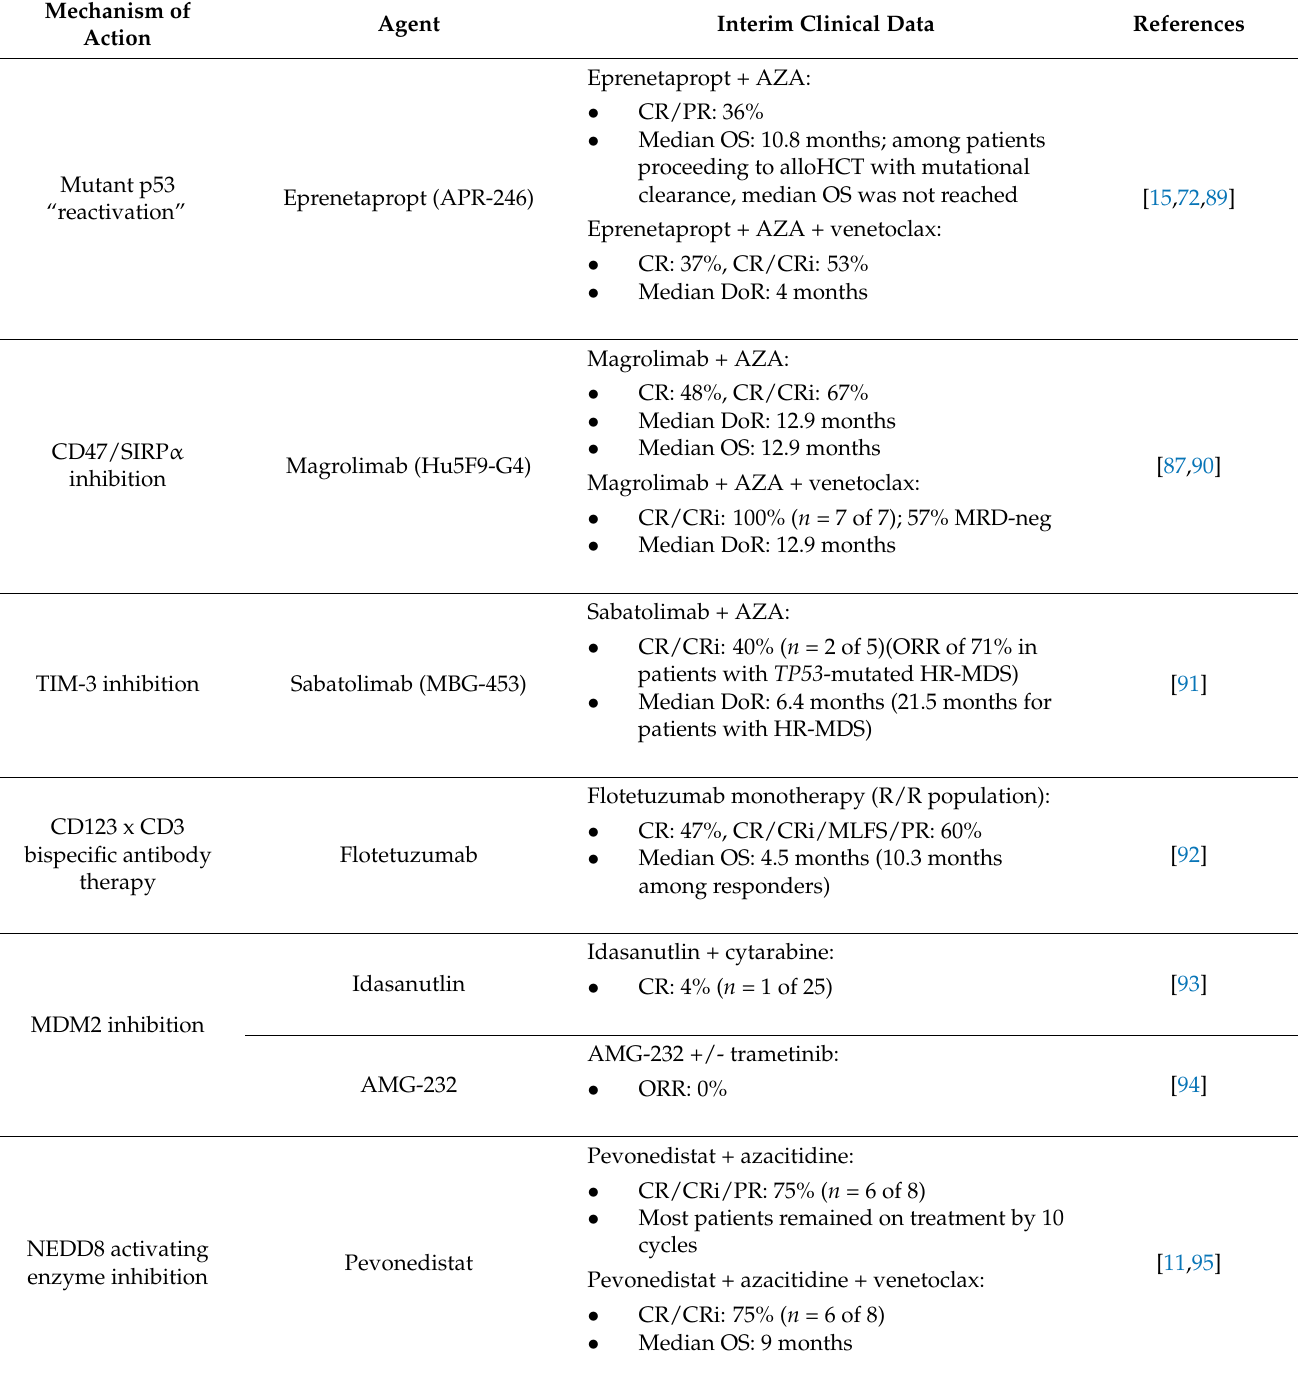
Table 2. Summary of known clinical data for emerging/novel therapies for TP53 -mutated AML. Mechanism